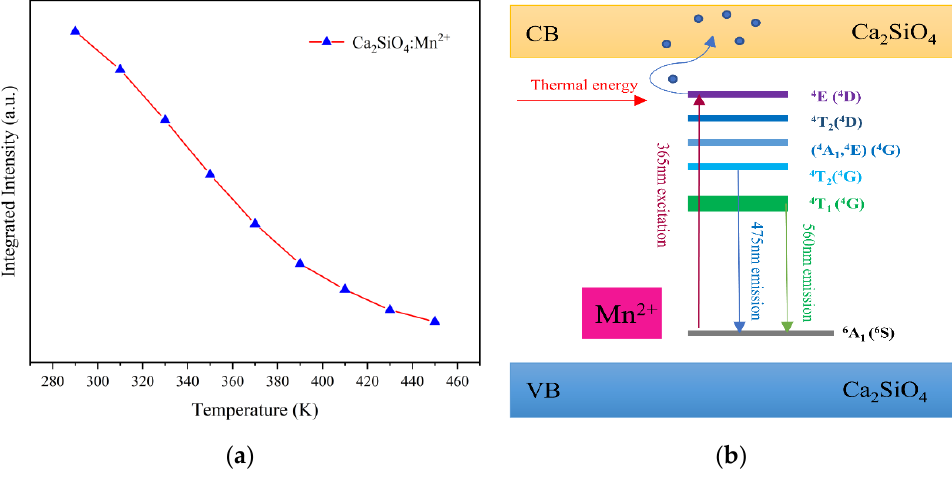
Figure 6. ( a ) Temperature dependence of the integrated intensity of CSO:Mn 2+ . ( b ) Energy-level diagram and the fluorescence process of CSO:Mn 2+ .